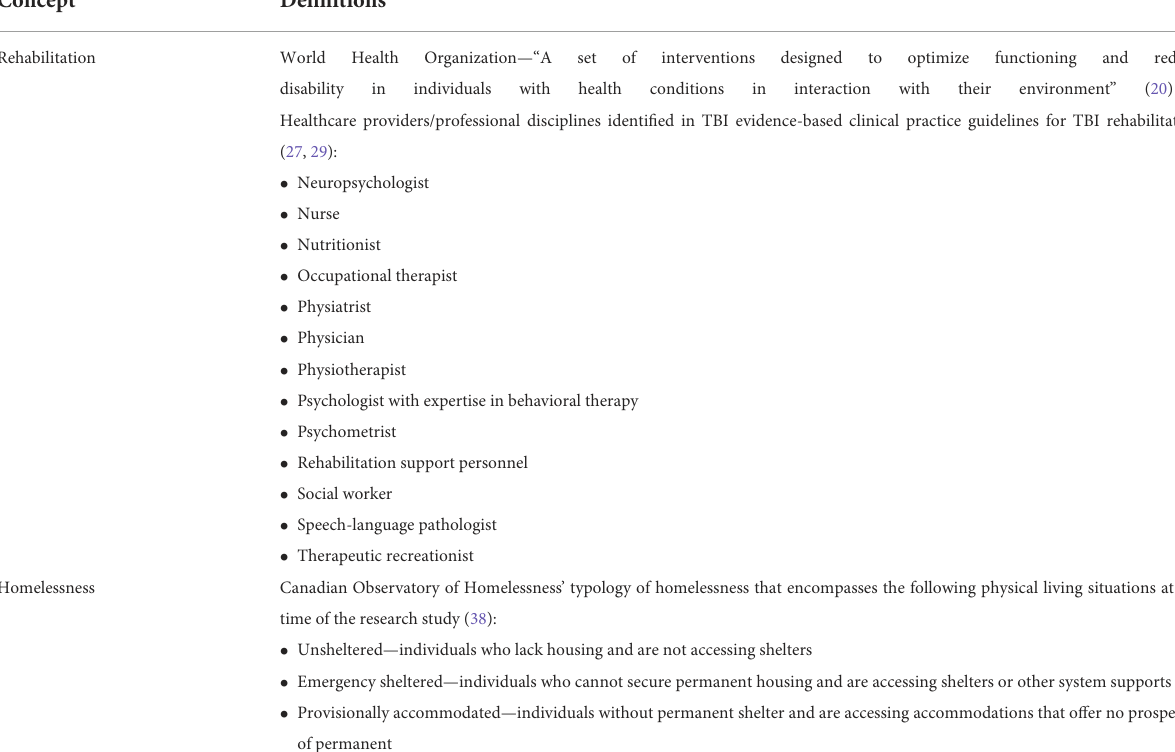
TABLE 1 Definitions of rehabilitation and